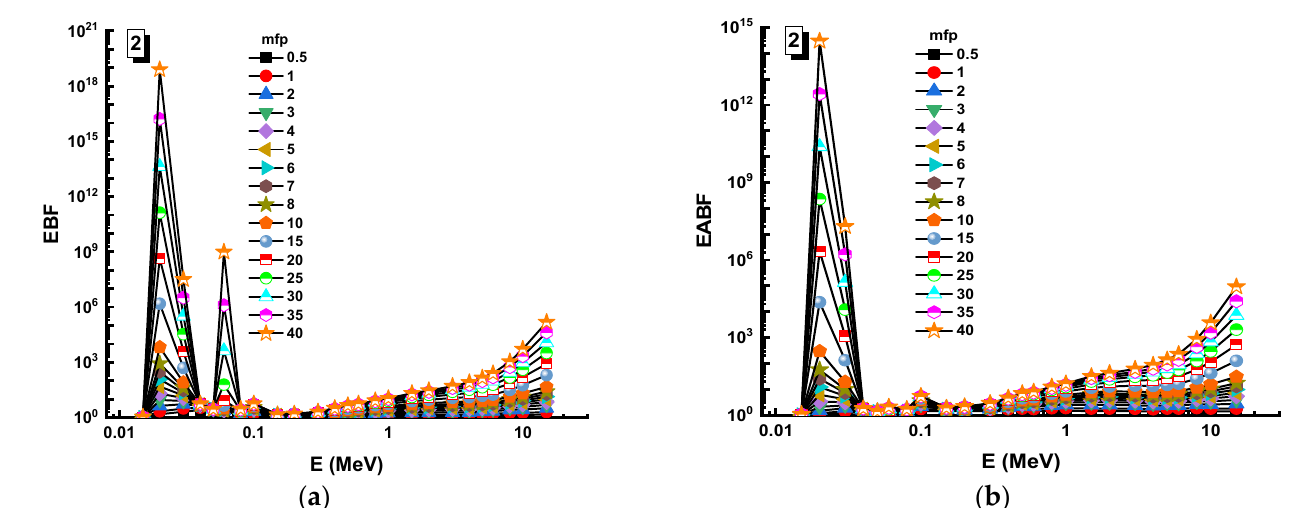
Figure 9. Variation of ( a ) EBF and ( b ) EABF against photon energy for Sample 2.